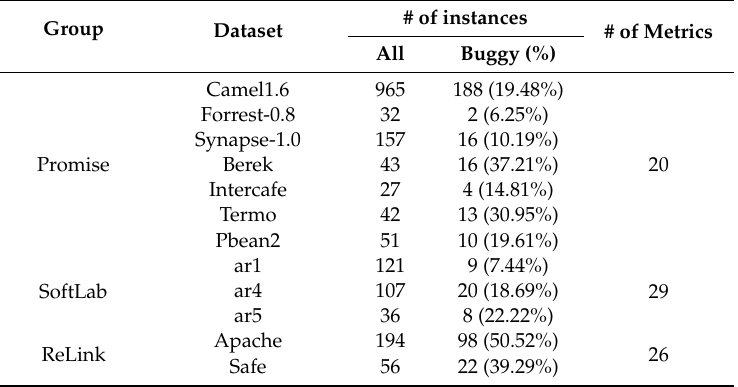
Table 3. Overview of experimental datasets.